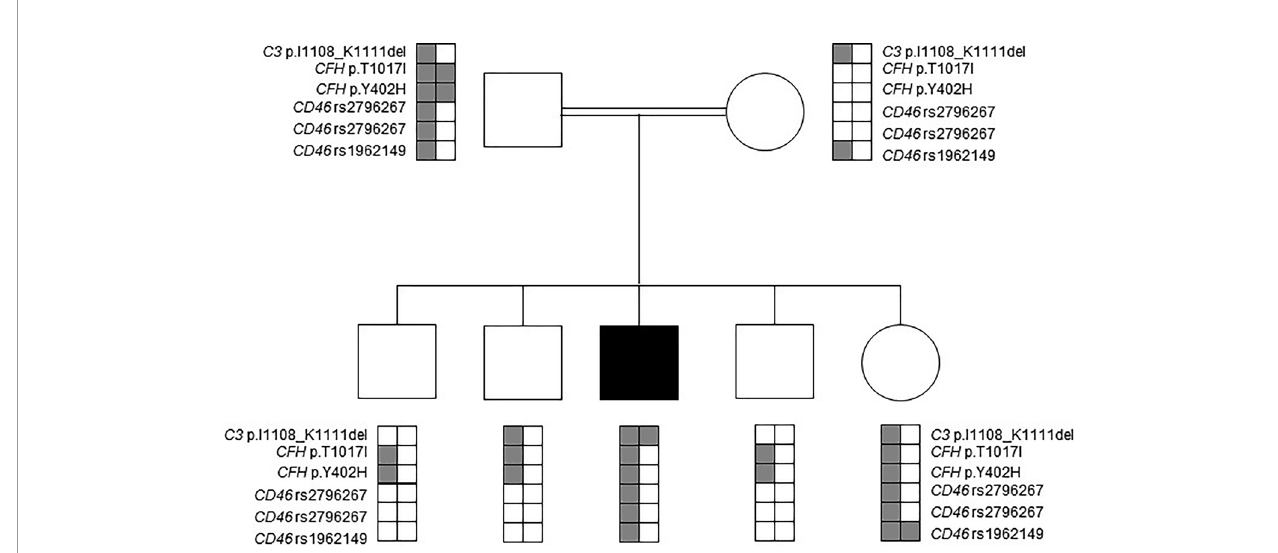
FIGURE 1 | Mutation analysis in the patient ’ s nuclear family. Affected individual is marked by a black fi lled square. Rare alleles of the rs2796267, rs2796268 and rs1962149 polymorphisms and their haplotype referred as MCP ggaac were reported to be a risk factor for developing aHUS.